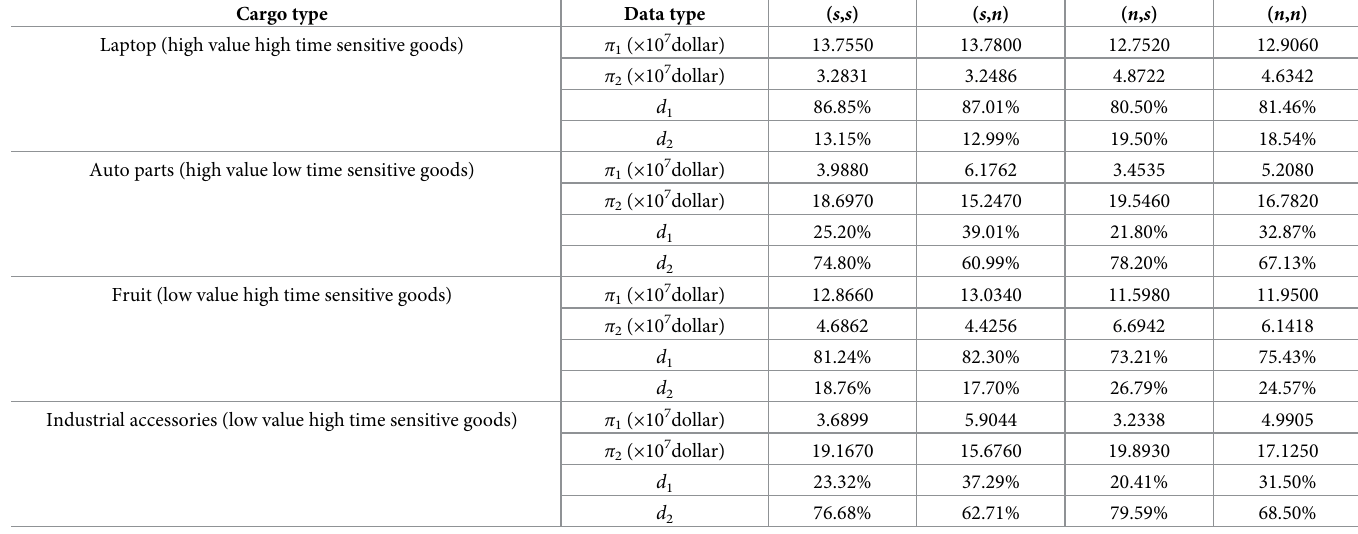
Table 7. Market share and profit (without subsidy) of CR Express and shipping at different service levels. Cargo